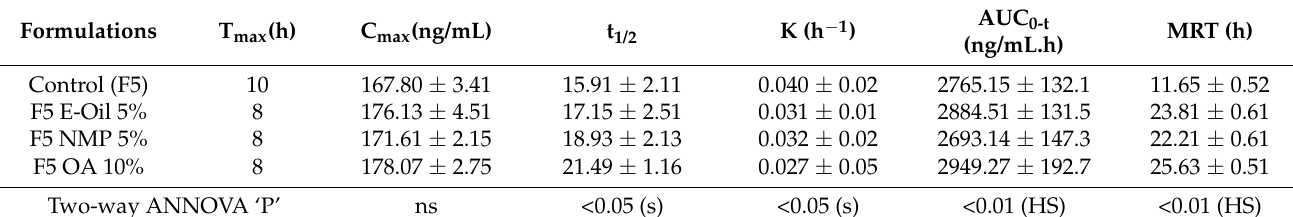
Table 7. Evaluation of pharmacokinetic parameters of control and optimized methotrexate